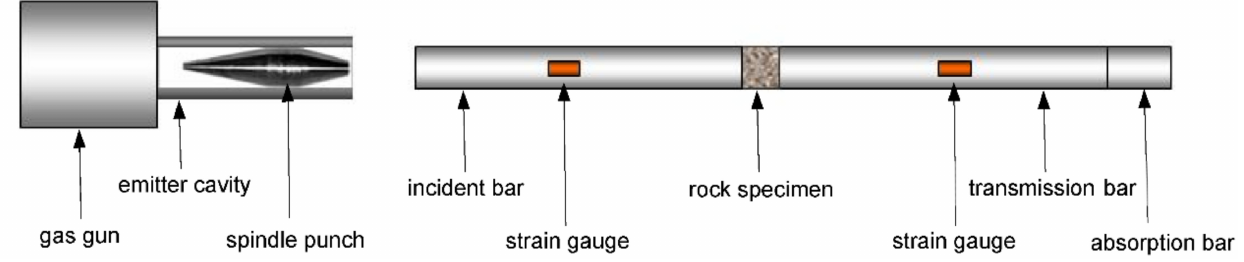
Figure 1. Sketch of split Hopkinson pressure bar (SHPB)